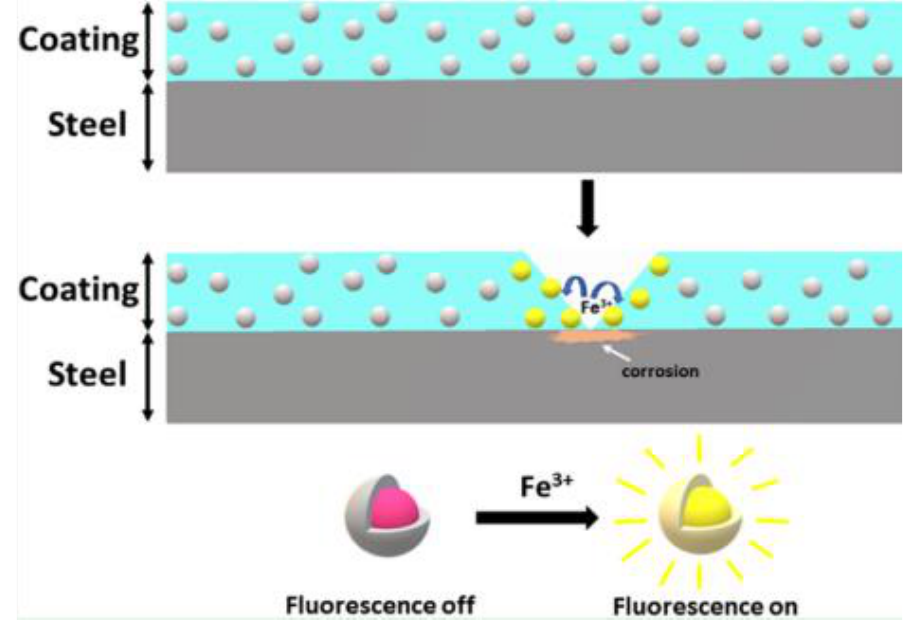
Figure 13. The principle of corrosion triggered fluorescent microcapsules. (Reprinted from ref.